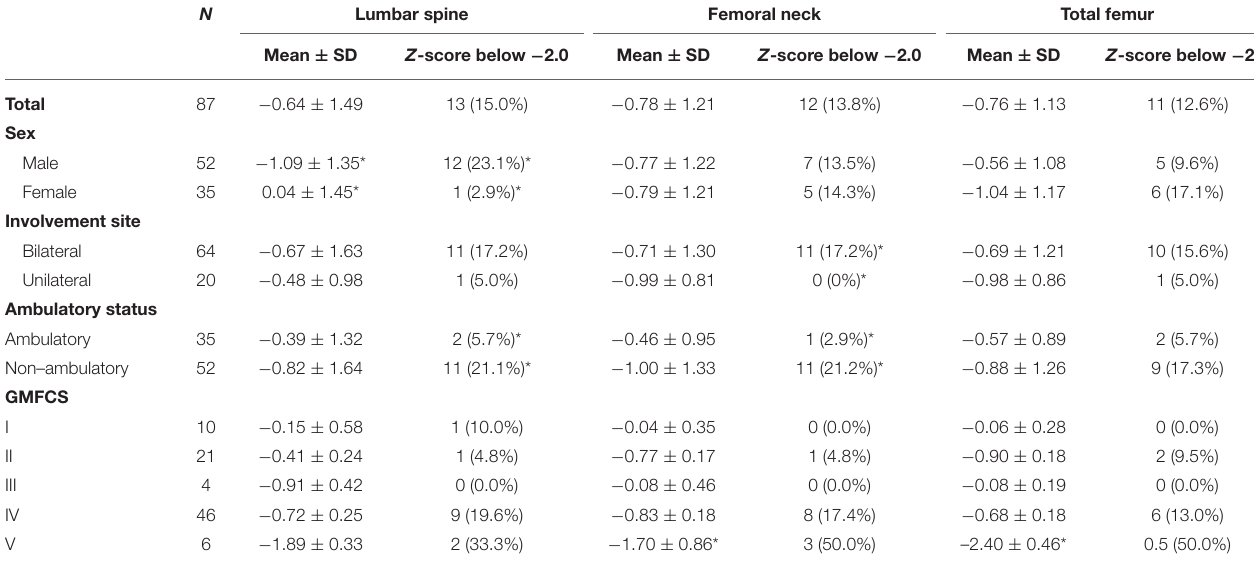
TABLE 2 | Z -scores and “low BMD” group for sex, involvement site, and ambulatory status. N